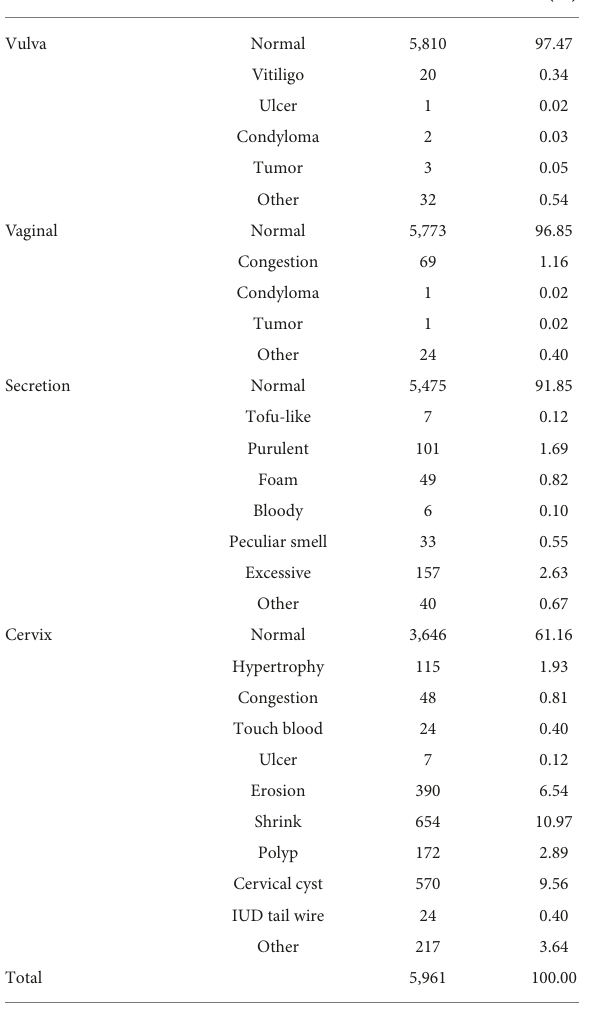
TABLE 6 Gynecological examination of the cervical cancer screening population. Characteristics